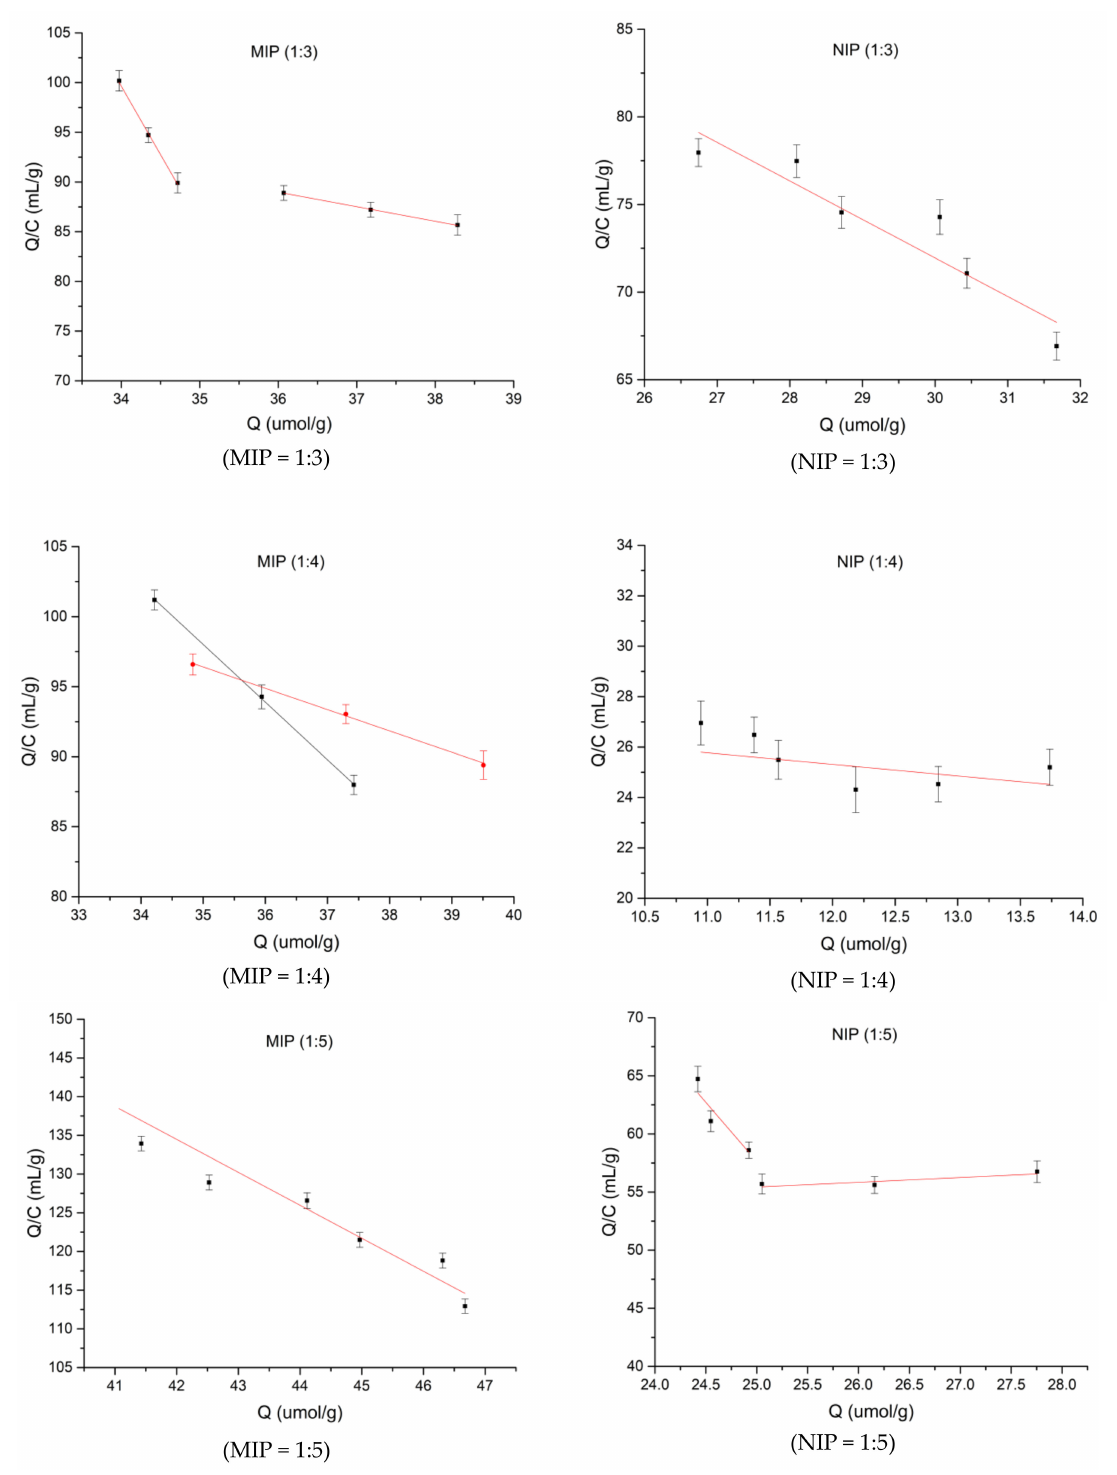
Figure 4. MIP/NIP Scatchard fitting figure. Note: MIP and NIP from left to right (at 25 ◦ C, constant temperature